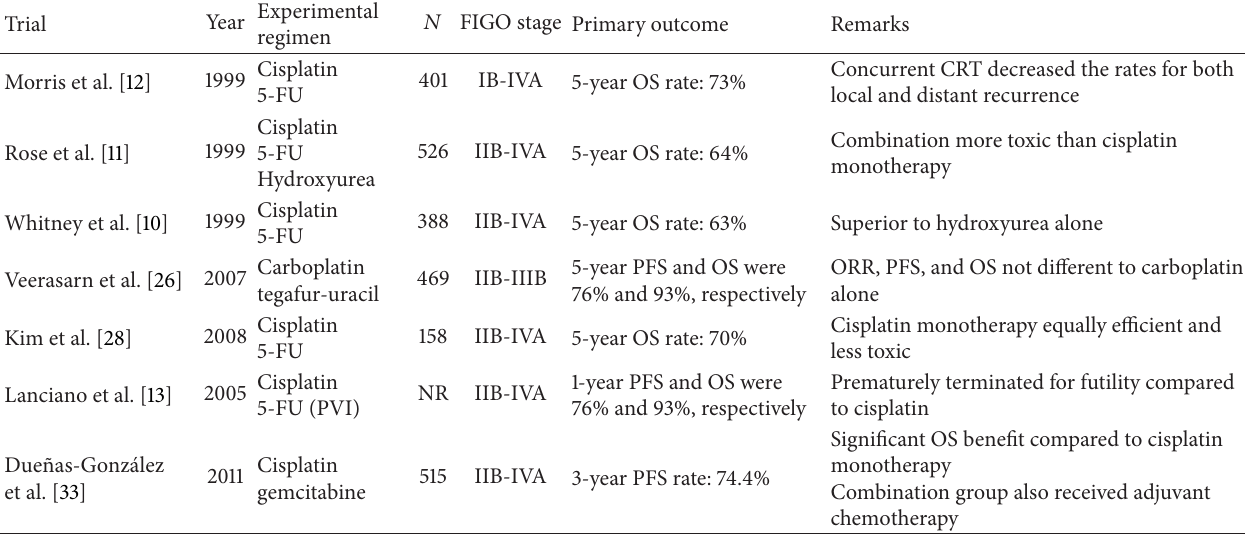
FIGO: International Federation of Gynecologic Oncology; CRT: chemoradiotherapy; OS: overall survival; PFS: progression-free survival; ORR: objective response rate; 5-FU: 5-fluorouracil; PVI: protracted venous infusion; 𝑁 : number of